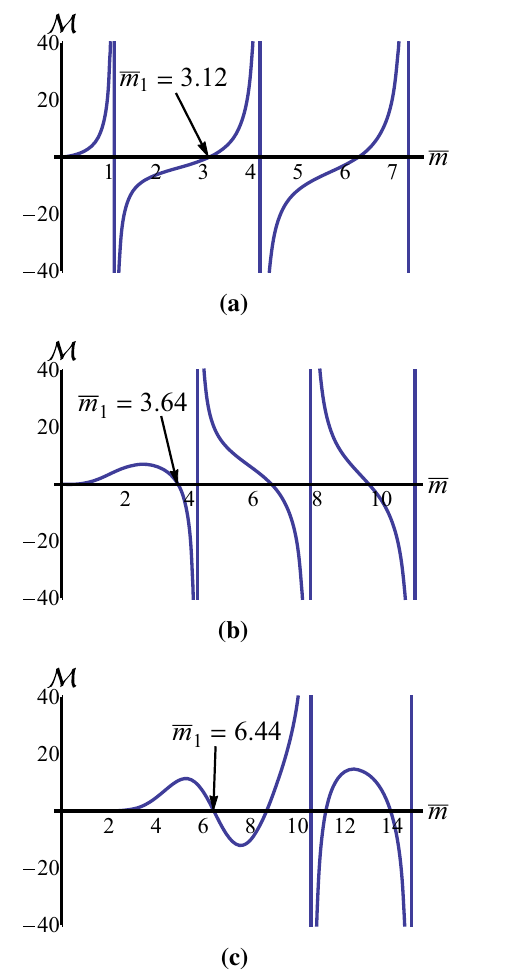
Fig. 1 Theeffectoftheparameter λ onthemass ¯ m 1 ofthefirstmassive scalar KK mode. The other parameters are set to k = − 3 and ¯ z b = 1